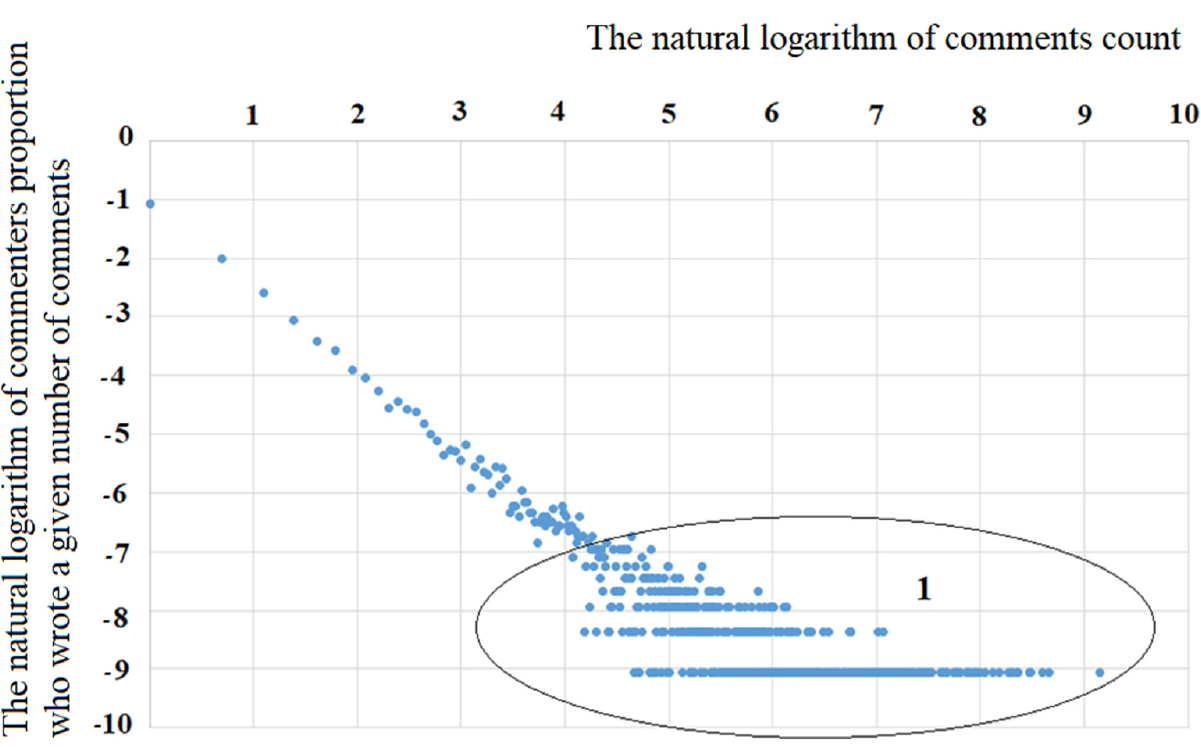
Figure 4. Linearization of the observed data for power distribution.